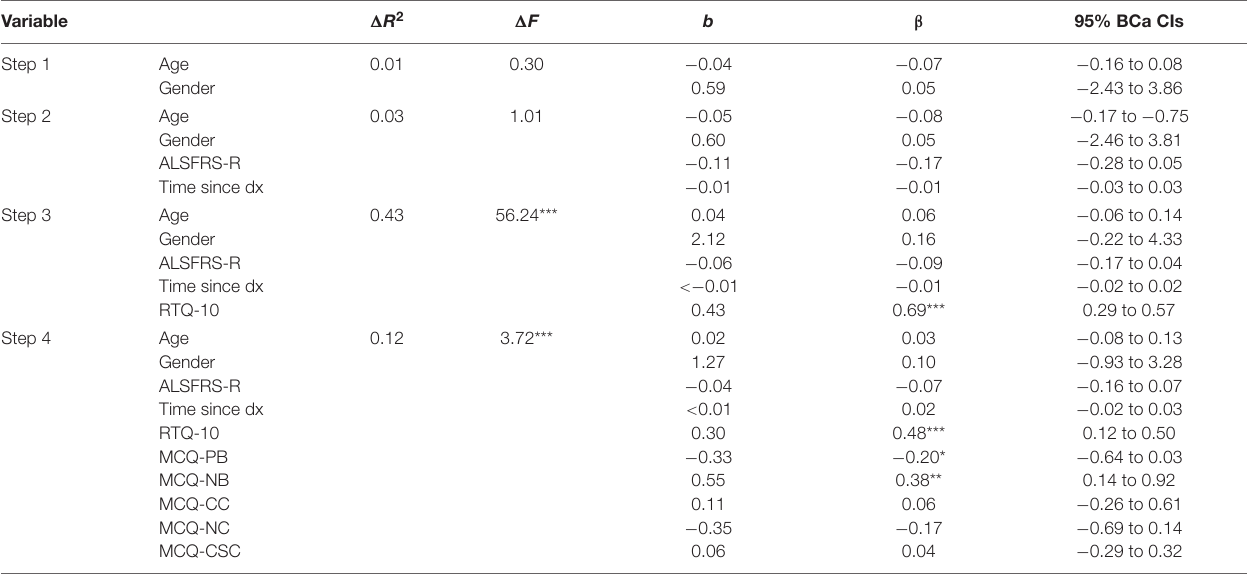
TABLE 3 | Hierarchical multiple linear regression model predicting emotional